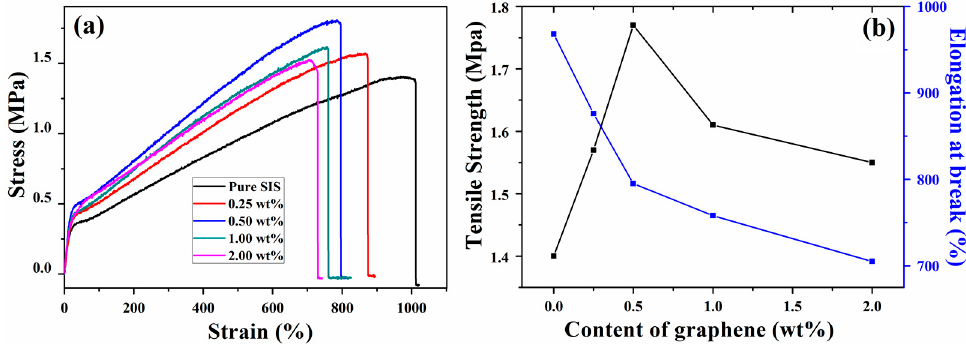
Figure 3. Stress–strain curves ( a ) and mechanical properties ( b ) of graphene/SIS composites.